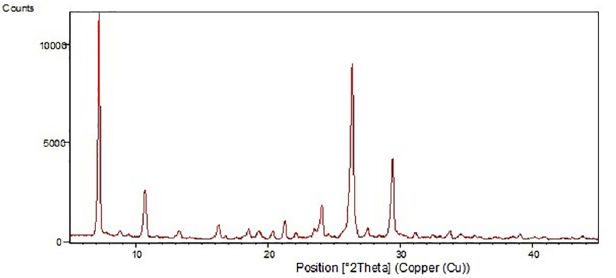
FIGURE 2 - PXRD patterns of acyclovir.